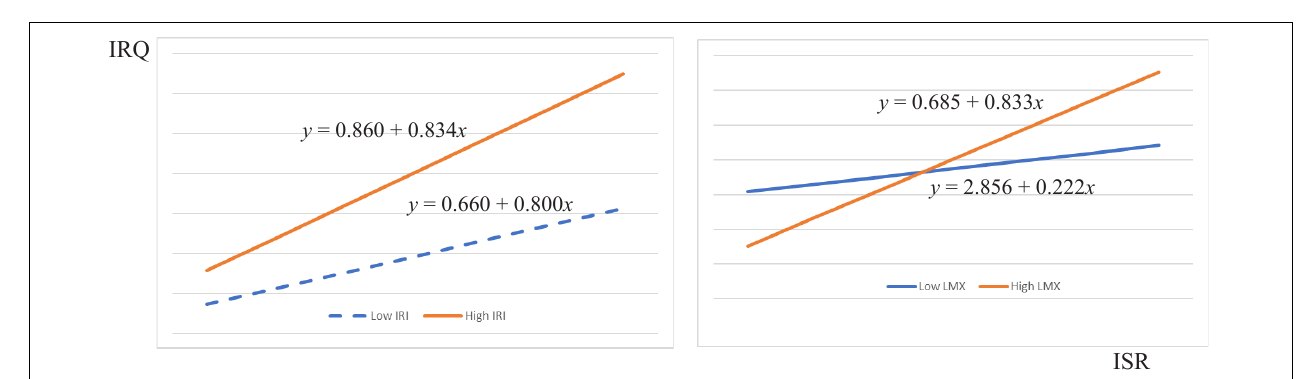
FIGURE 4 | Interaction diagram of IRI and LMX between ISR and IRQ in mainland China.